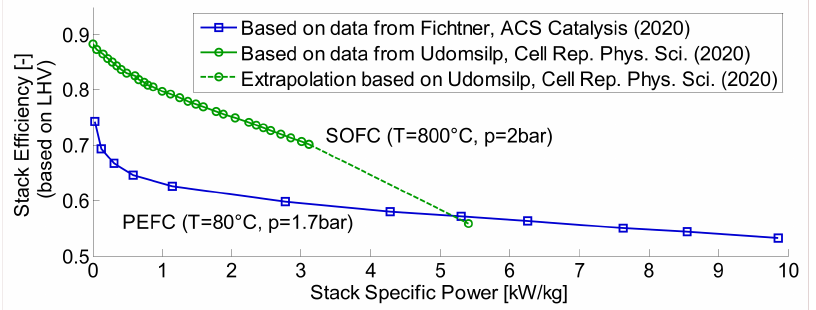
Figure 8. Performance characteristics of selected lab-scale PEMFC and SOFC technology concepts, calculated based on the assumptions specified in Appendices A.2–A.4.